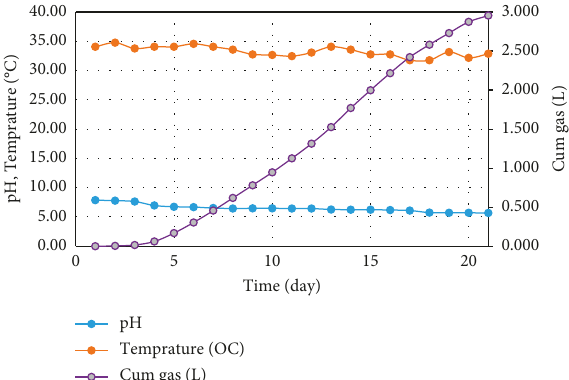
Figure 4: Relation between temperature, pH, and amount of gas produced from WW only.